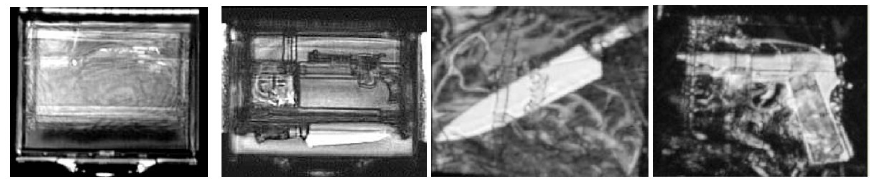
Figure 37. Reflection terahertz